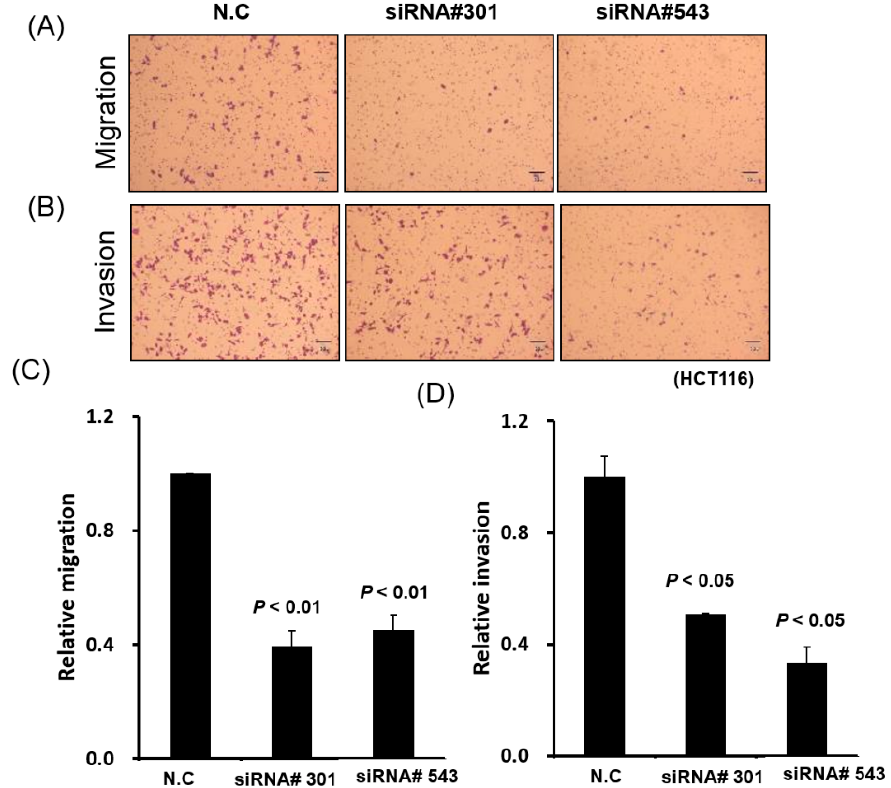
Figure 5. LOC550643 knockdown suppressed colon cancer cell migration and invasion abilities. ( A , B ) LOC550643 was knocked down through the transfection of siRNA into HCT116 cells, and their migration and invasion abilities were assessed through the transwell migration assay. ( C , D ) Relative migration and invasion abilities were further quantified using Ascent software.